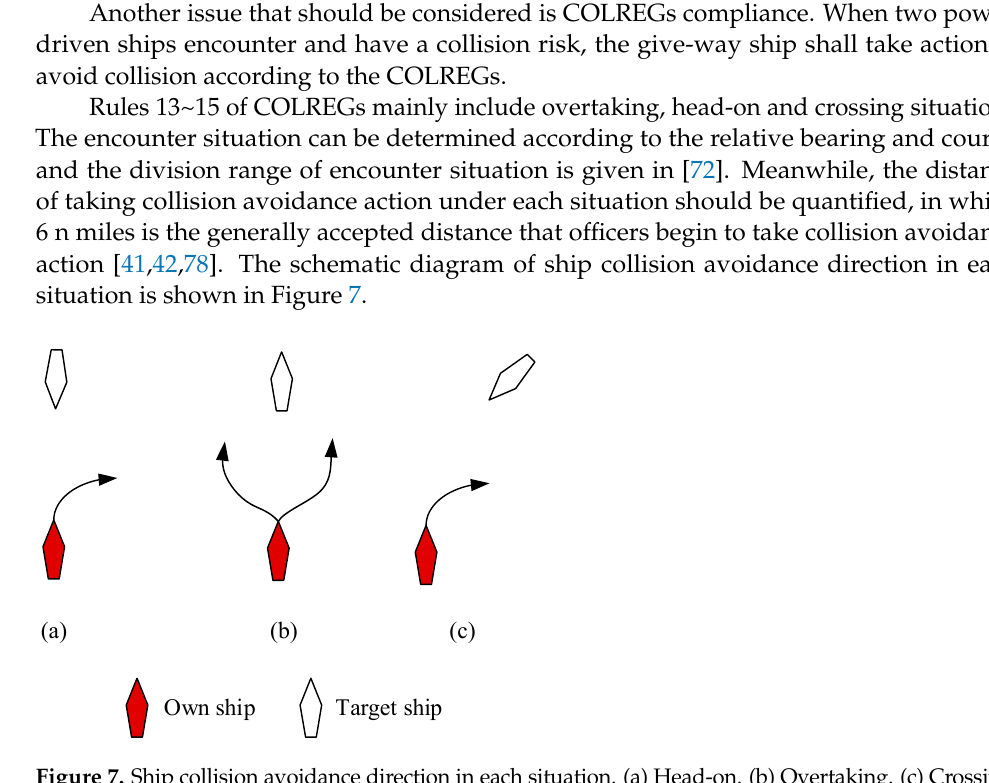
Figure 8. The sampling space result of half ellipse in head-on and crossing situation area. 3.3.3. Local Path Planning Algorithm In local path planning, the dynamic risk detection model is introduced by consider- ing one extra parameter of time. At the same time, in order to adapt to the encounter sit- uations, ship manoeuvrability restrictions are also included in local path planning algo- rithm. According to COLREGs, the ship collision avoidance distance and direction are quantified, and are considered in the planning path generation. The pseudo-code of local path planning algorithm under dynamic environment is shown in Algorithm 3. Algorithm 3 : Local path planning algorithm under ship dynamic collision risk Input: OS position X own ; Next waypoint X np ; static obstacles O sta ; Distance step D p ; Dynamic ob- stacles O dyn ; Samples probability P r ; Iterative time M ; maximum turning angle A max Output: Local planned path Path l 1: